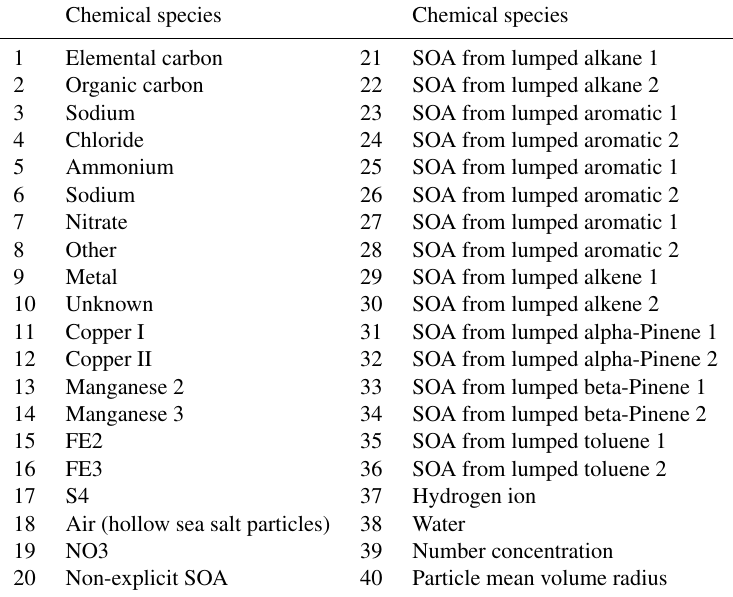
Table 1. Chemical species that are carried in the AQC/CLDAQC “species” dimension. All species are in concentrations (µgm − 3 ) except for the last two elements (i.e., 39 and 40), which carry the number concentration (#m − 3 ) and radius (m). SOA denotes secondary organic